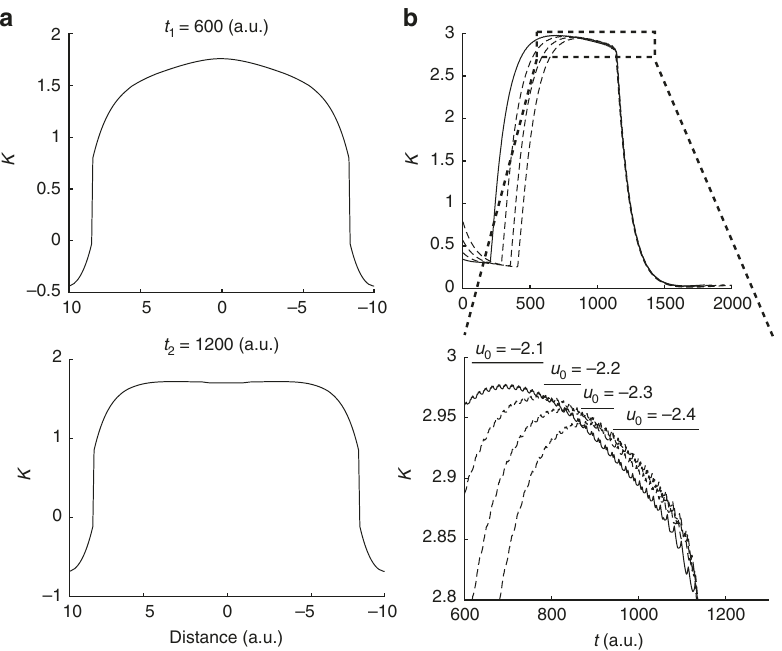
Fig. 5 The spatial source of ictal spike-and-wave discharges. The variable K , which combines the slow permittivity variable and the average activity of the fast population, determines in part the spatial source of SWDs. The variable K represents the instantaneous values of slowly evolving processes during the seizure and it can evolve differently for different parts of the fi eld during a seizure, thus resulting in a moving source for the SWDs (Methods). a Evolution of the variable K during a seizure indicated by two different snapshots ( t 1 and t 2 ). b Top plot: the variable K as a function of different excitability levels including v 0 = − 2.1 (full line) and for values ranging from − 2.4 to − 2.2 (dashed lines), at a speci fi c site of the Epileptor fi eld model. Bottom plot: zoomed in view of the top plot. The maxima of the variable K (black bars) computed over space, therefore corresponding to the sources of propagation, are obtained by comparing K for different values of u 0 at each time